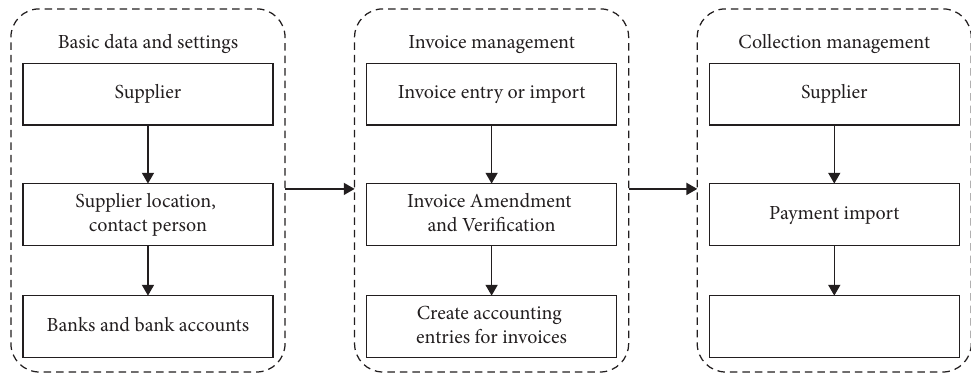
Figure 5: Core functions and business fowchart of accounts receivable